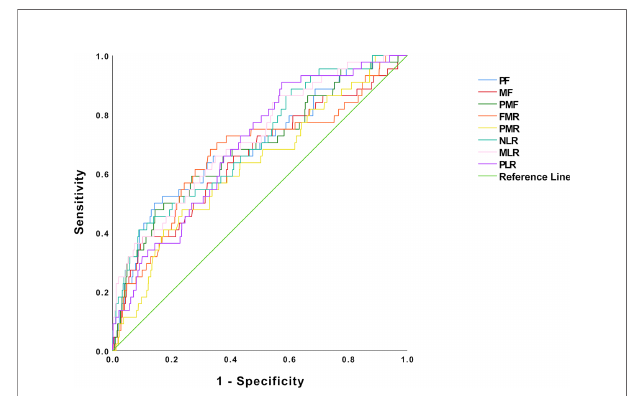
FIGURE 2 | Optimal cutoff points for hematologic parameters were on with ROC curves. PF, platelet count* fi brinogen; MF, mean platelet volume* fi brinogen; PMF, platelet count*mean platelet volume* fi brinogen; FMR, fi brinogen-to-mean platelet volume ratio; PMR, platelet count-to-mean platelet volume ratio; NLR, neutrophil count-to-lymphocyte count ratio; MLR, monocyte count-to-lymphocyte count ratio; PLR, platelet count-to- lymphocyte count ratio; ROC, receiver operating characteristic.